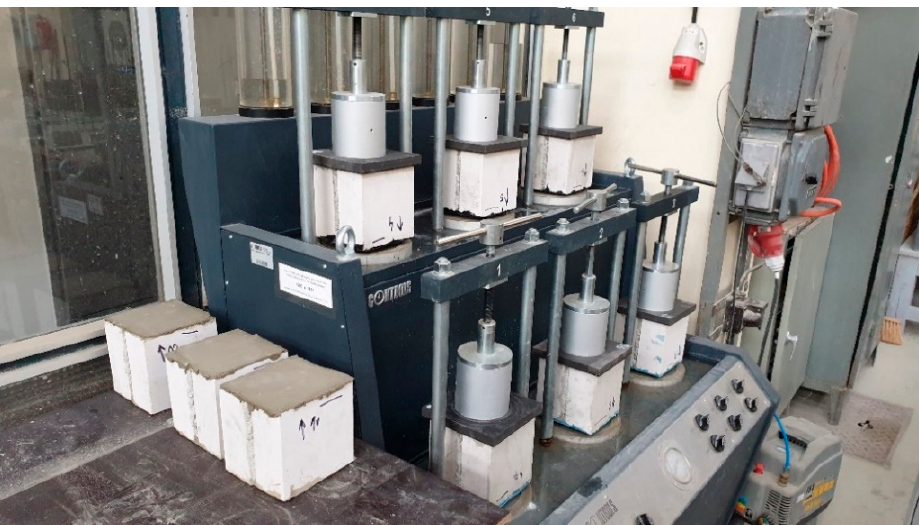
Figure 4. Water pressure test on the sets of specimens.